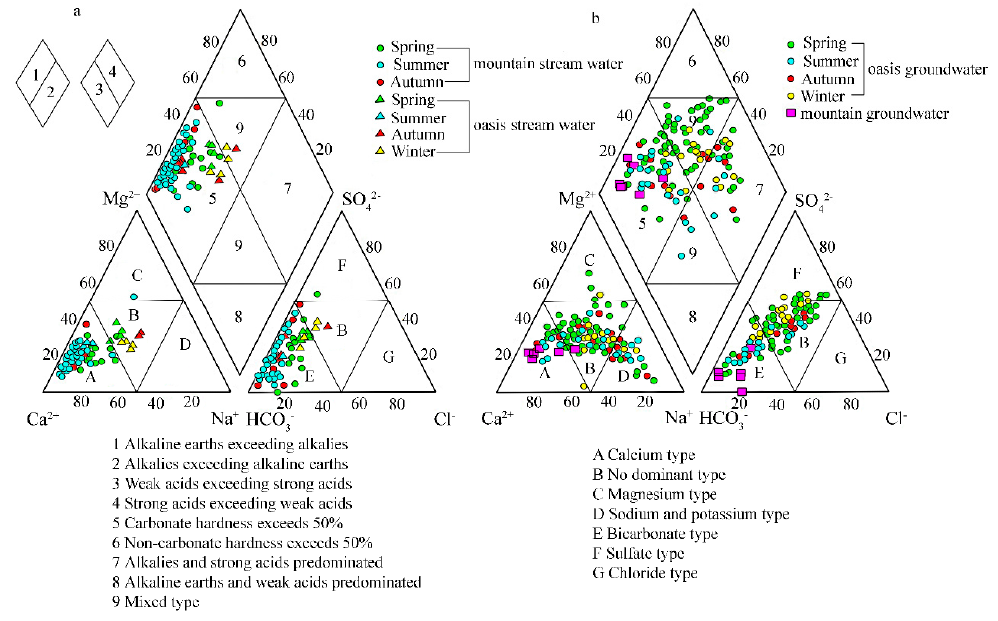
Figure 3. Piper diagrams of ( a ) stream water and ( b ) groundwater in different seasons.